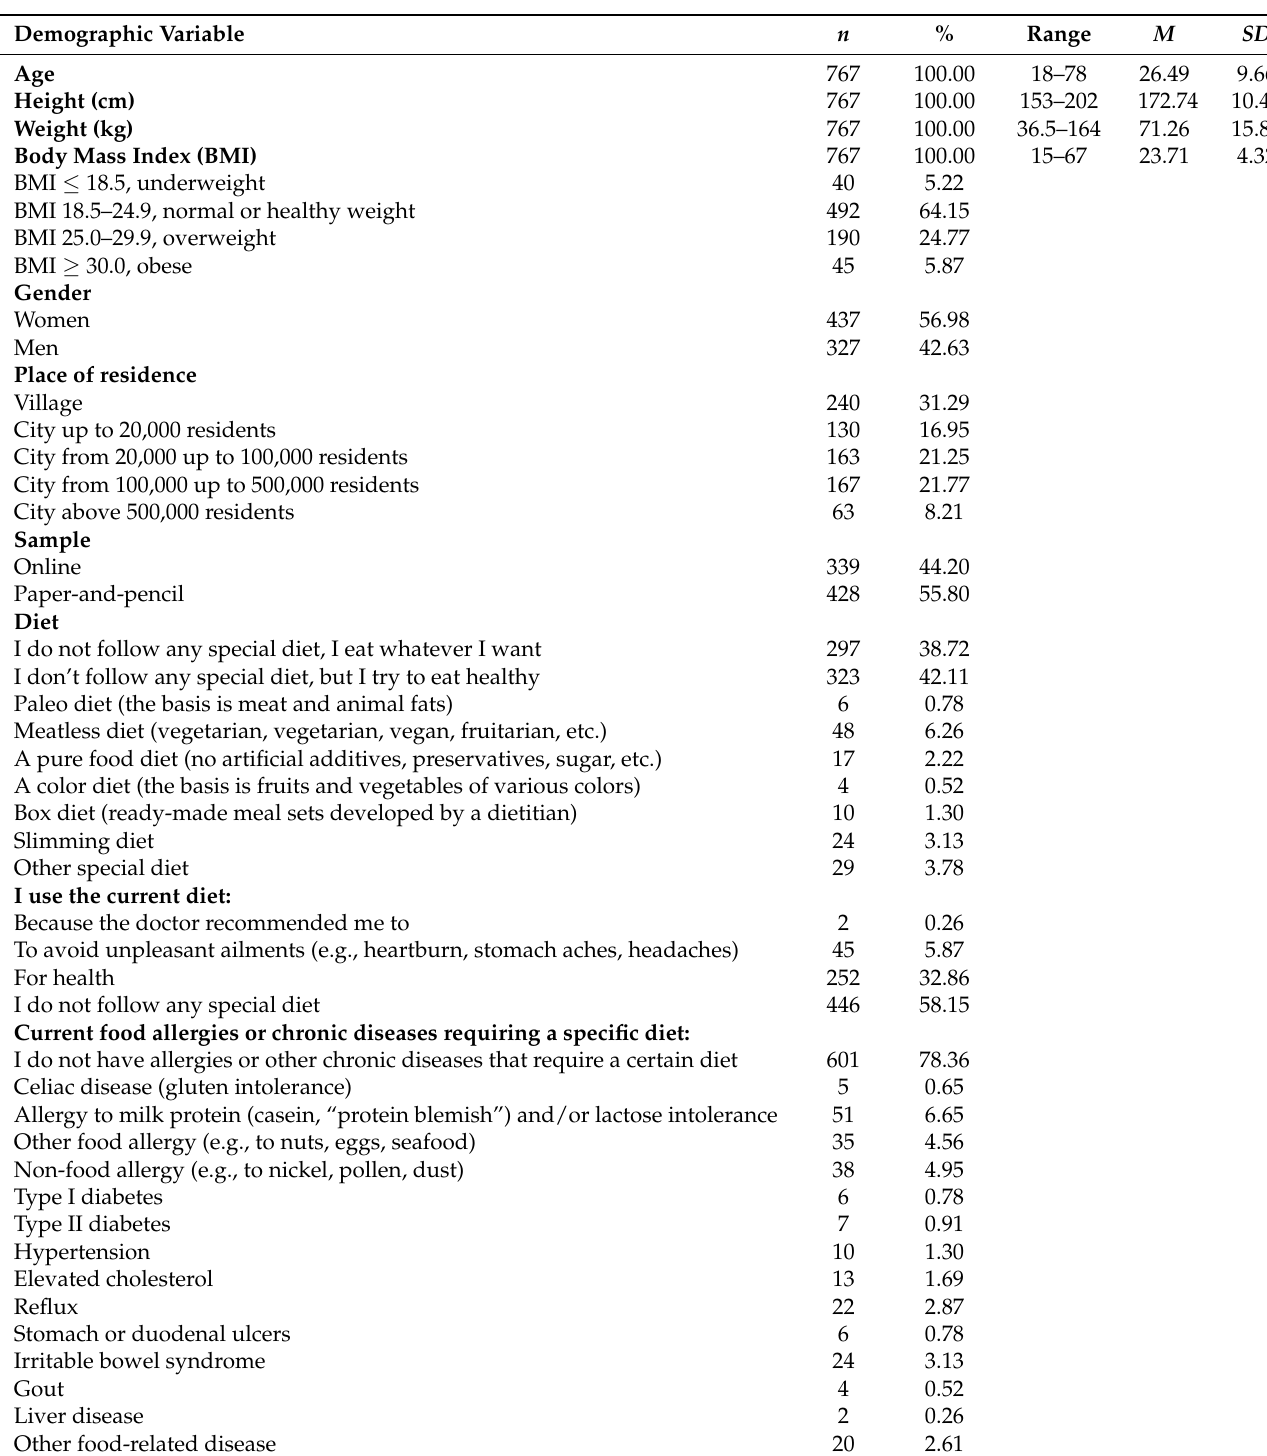
Table 1. Demographic characteristic of the study